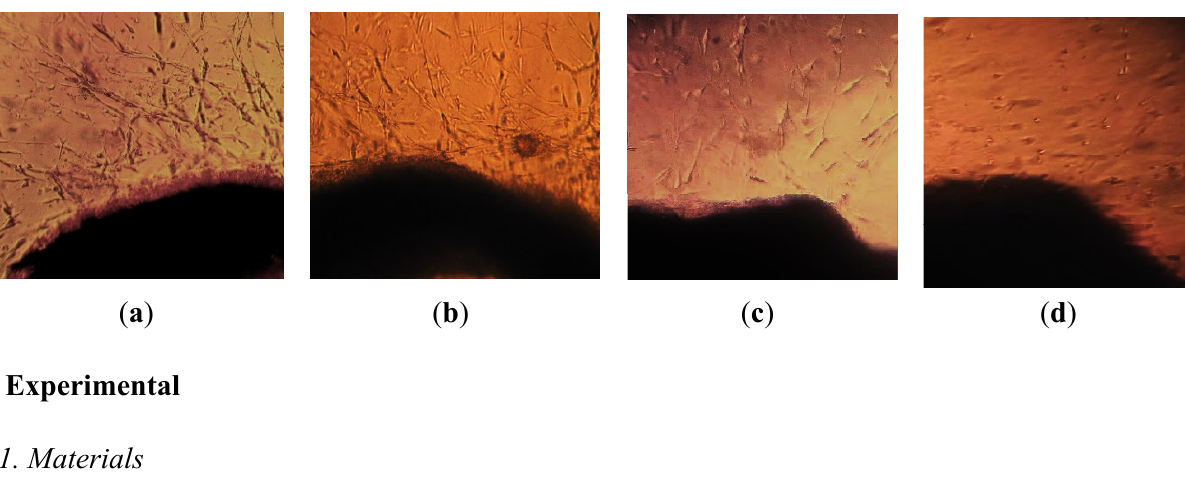
Figure 6. The inhibitory effects of silver nanoparticles on appearances vascular like appendages from the aortic rings. ( a ) Control; ( b ) The concentration of 50 μ g/mL wasn’t able to inhibit destroy vessel; ( c ) modular inhibitory effect on 200 μ g/mL; ( d ) Strong inhibitory effect 300 μ